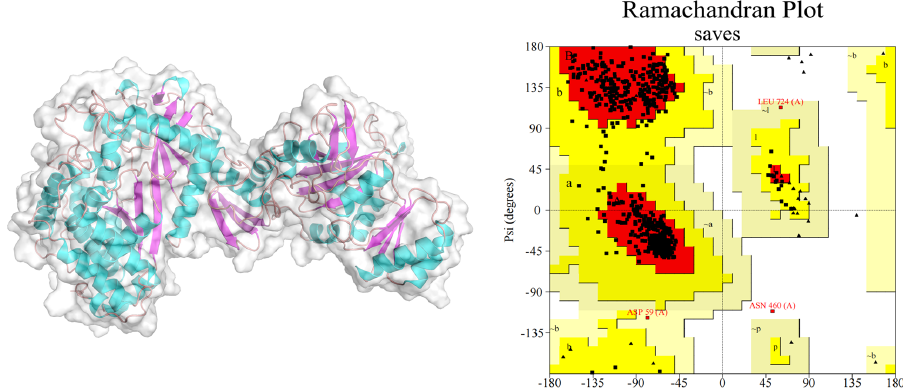
Figure 1. The Structure and Ramachandran Plot of GshFSA. The protein structure was simulated using Gromacs for 298 K, 318 K and 338 K with 100 ns. After energy minimization, pressure pre-equilibration, and temperature pre-equi- libration, root mean square deviation (RMSD) and root mean square fluctuation (RMSF) values were calculated. RMSD is used to indicate the structural changes of the protein